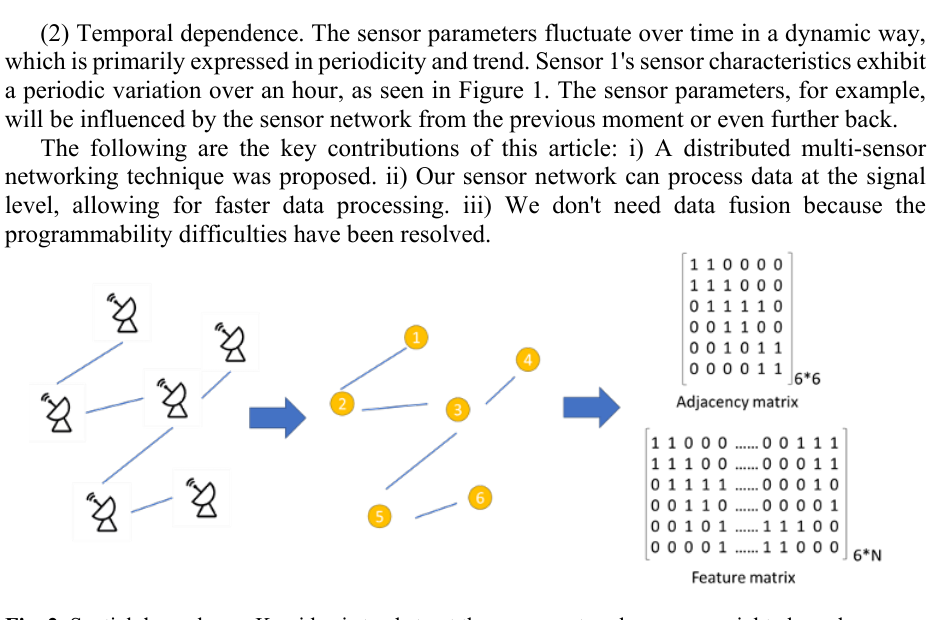
Fig. 2. Spatial dependence, Key idea is to abstract the sensor network as an unweighted